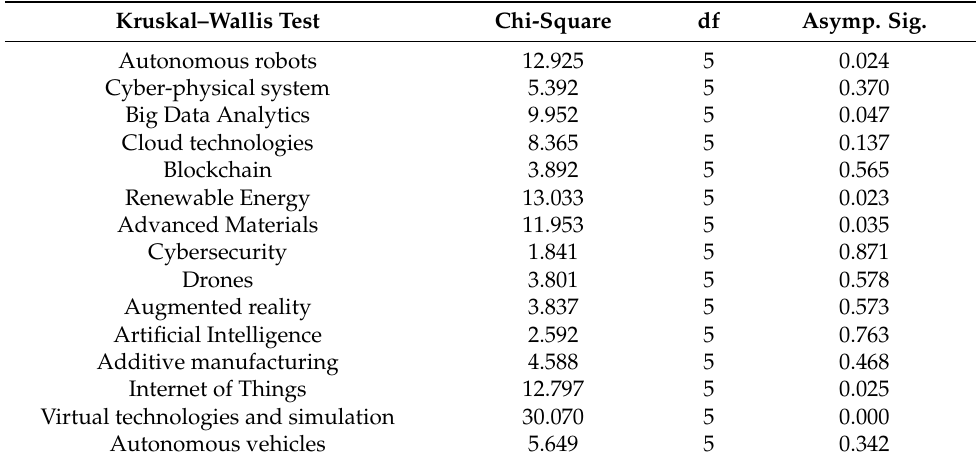
Table 12. Evaluation of null and alternative research